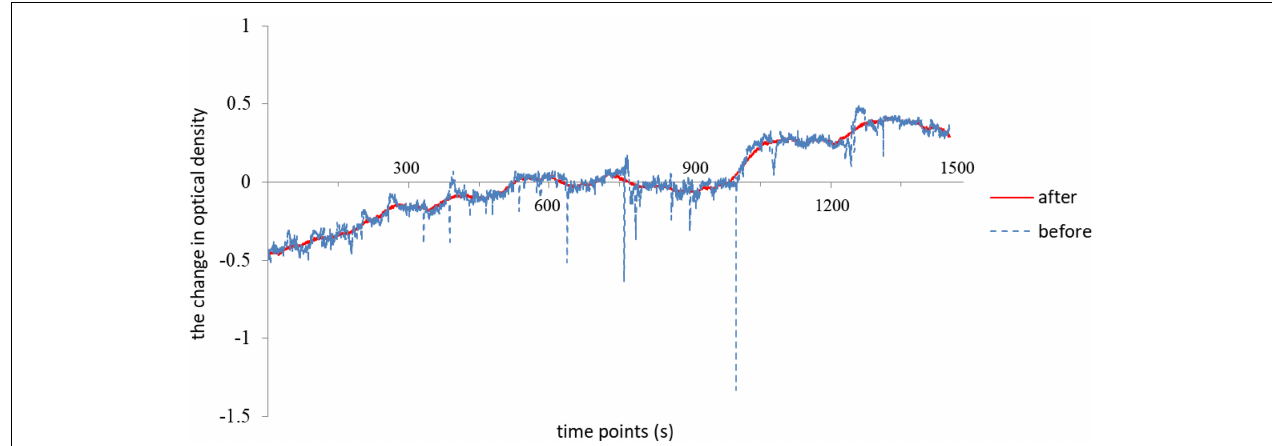
FIGURE 2 | The time series data changes in one channel of one subject before and after artifacts removal by using channel-based cubic spline interpolation.